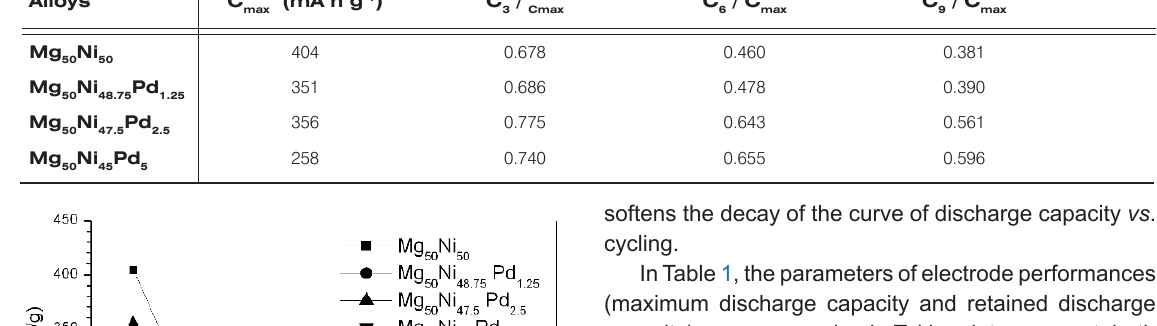
Table 1. Performance of the alloy electrodes.